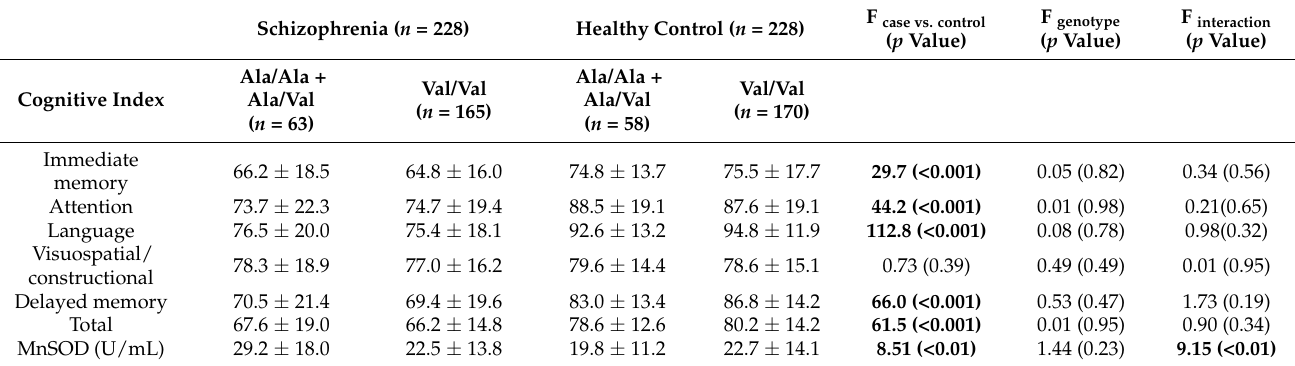
Table 3. Cognitive performance and plasma MnSOD activity in first-episode schizophrenia patients and normal controls grouped by MnSOD Ala-9Val